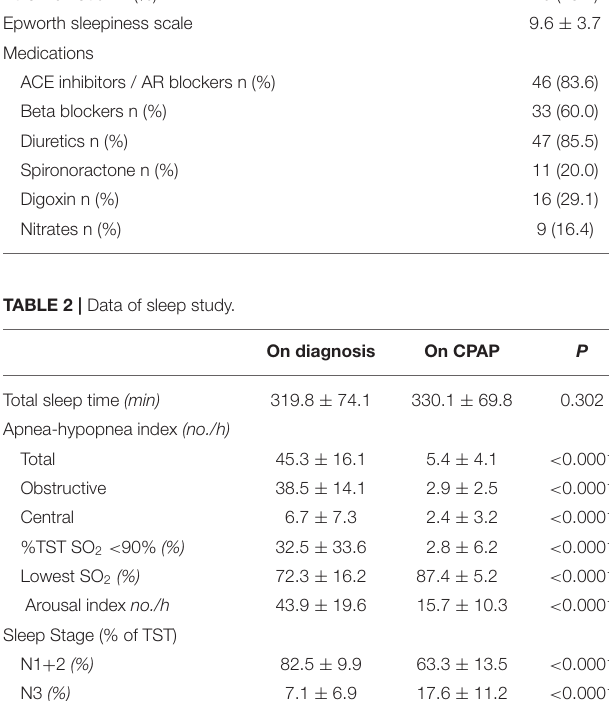
FIGURE 1 | Left ventricular ejection fraction (LVEF) improved from 37.2 to 43.2%, with a statistical significance after 1 month of CPAP treatment.